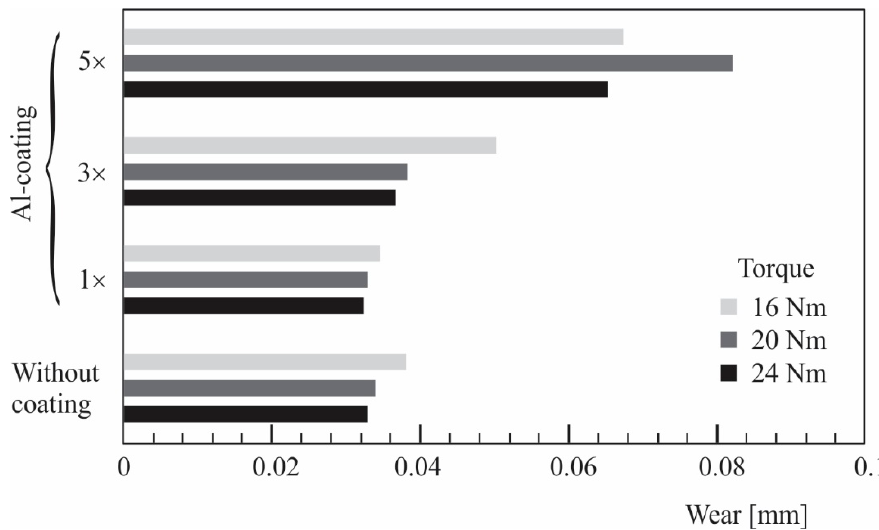
Figure 9. Wear of uncoated and coated polymer gears.